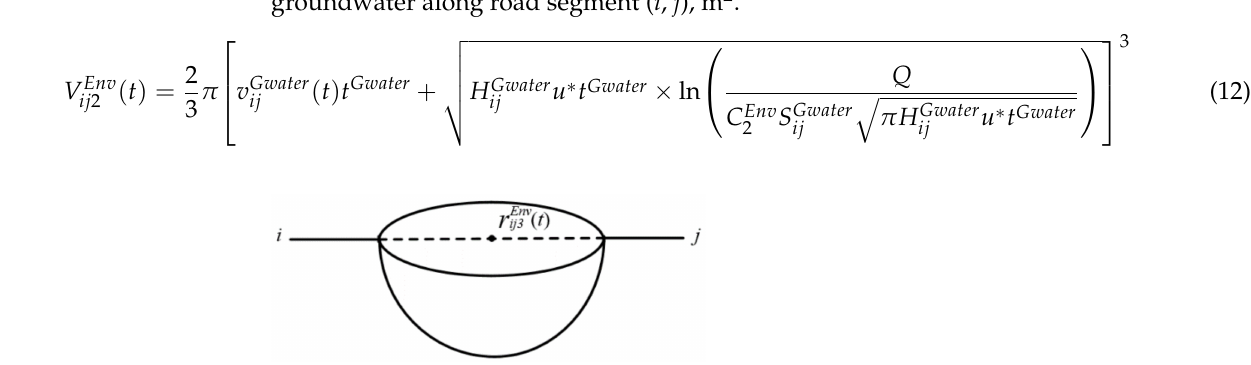
Figure 3. Accident influence area of groundwater pollution. Second, C Env